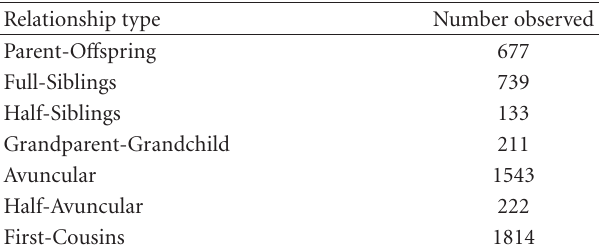
Table 1: Pedigree relationship types in the San Antonio family heart